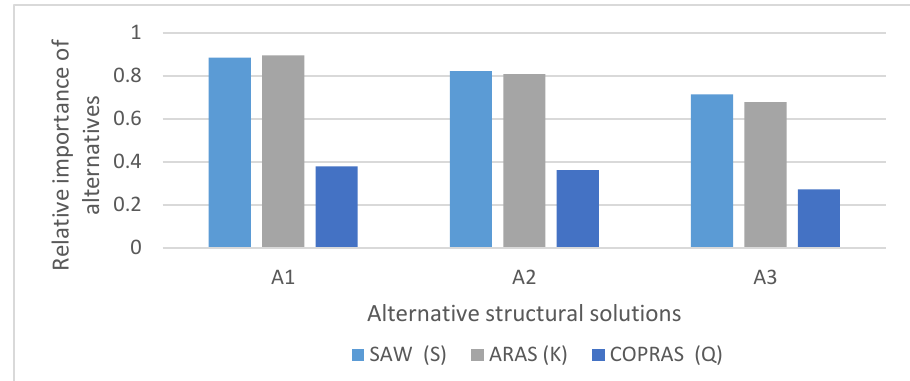
Figure 14. The comparison of the results of multi-criteria